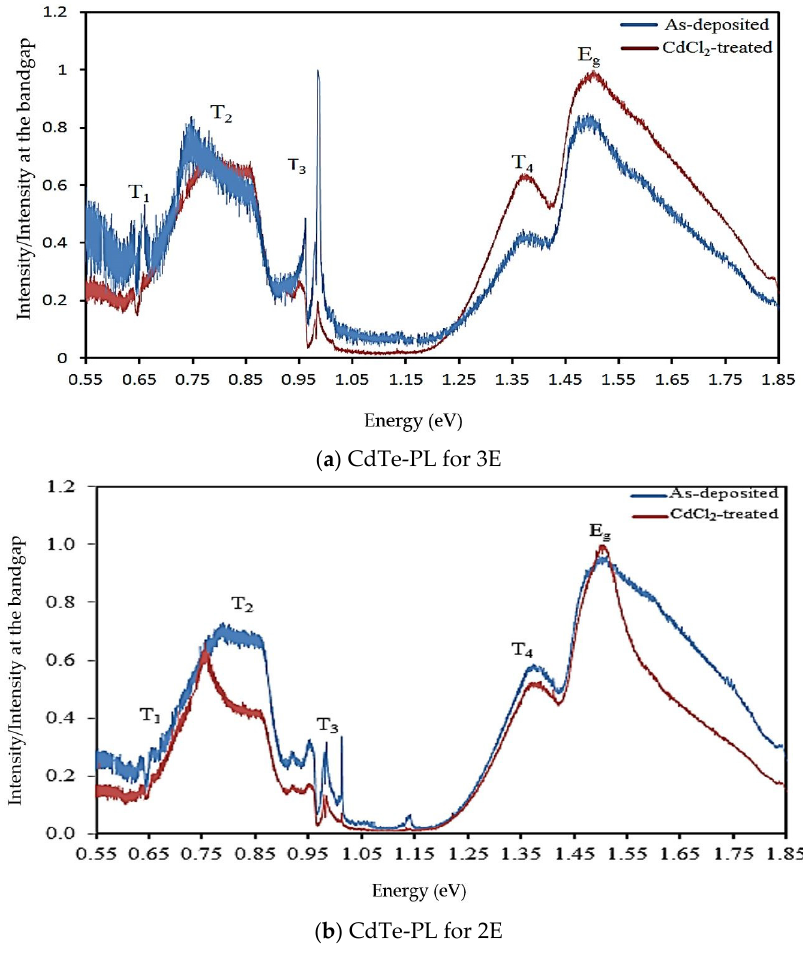
Figure 8. Photoluminescence spectra obtained for as-deposited and CdCl 2 -treated CdTe layers grown from ( a ) 3E and ( b ) 2E systems. Table 1. Summary of electron traps observed at 80 K for CdTe layers electroplated using the 3E and